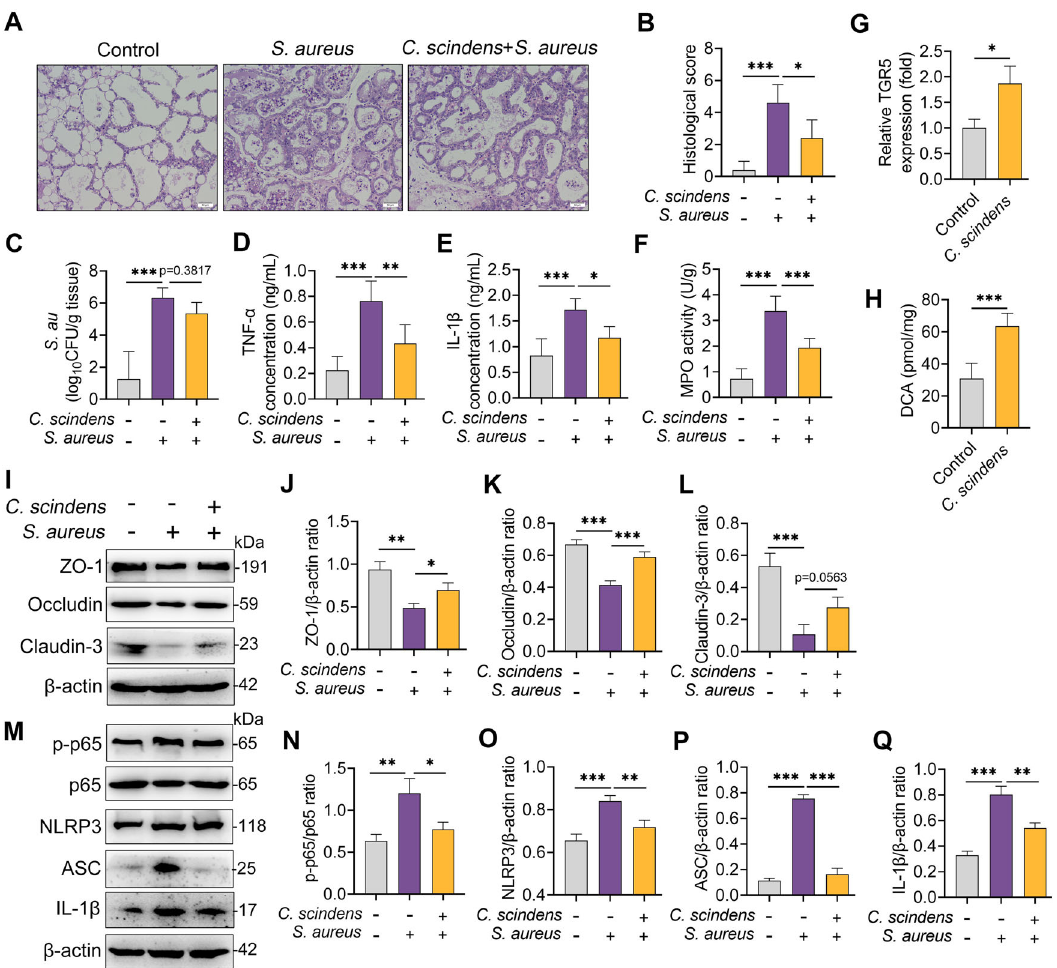
Fig. 7 Clostridium scindens with DCA-producing capacity alleviates S. aureus -induced mastitis in mice. A Representative images of the H&E-stained sections from different groups (scale bar, 50 μ m). B The histological score of the mammary gland from different groups ( n = 6). C Mammary S. aureus load ( n = 6). The proin fl ammatory markers of TNF- α ( D ), IL-1 β ( E ), and MPO activity ( F ) were measured ( n = 6). G Relative expression of TGR5 mRNA from different treated groups ( n = 6). H Mammary DCA levels from the indicated mice ( n = 6). I Representative